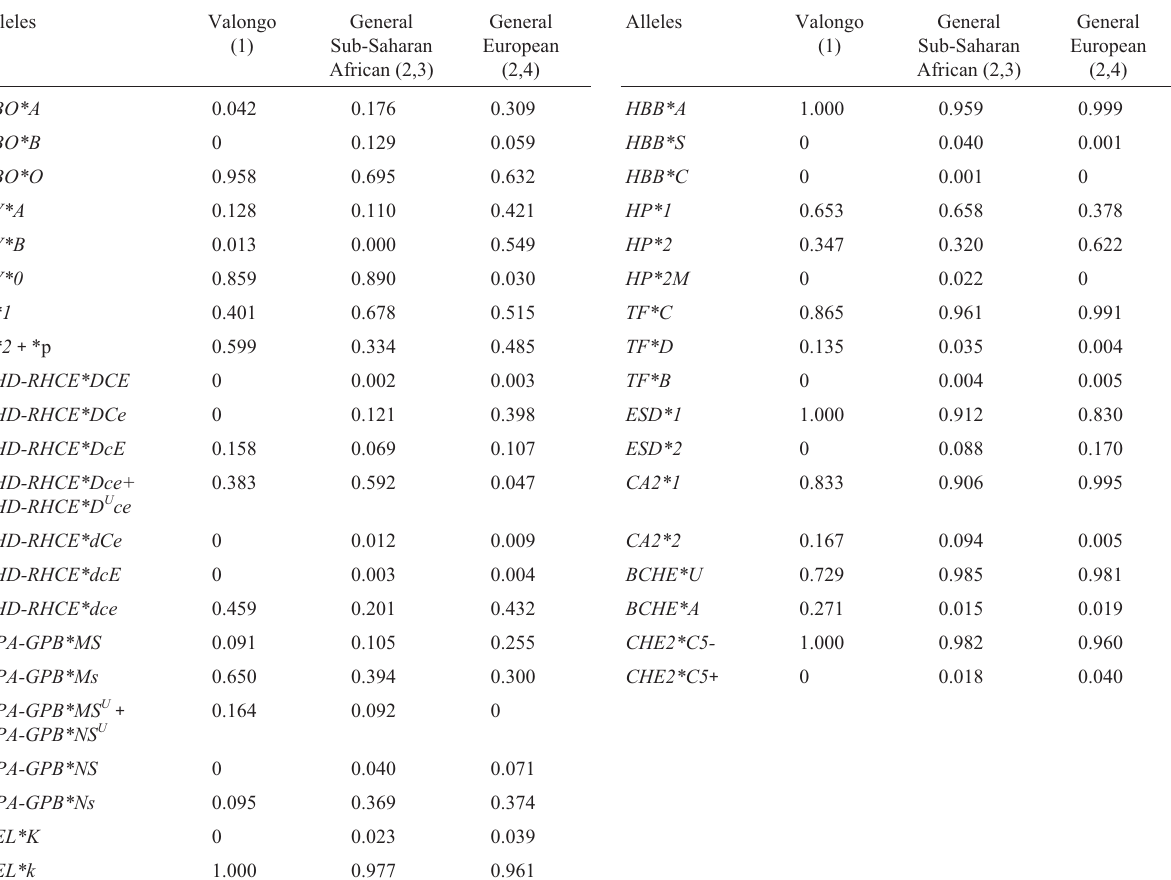
Table 2 - Distribution of allele frequencies of the analyzed loci in the community of Valongo, in Sub-Saharan Africans and in Europeans. Alleles